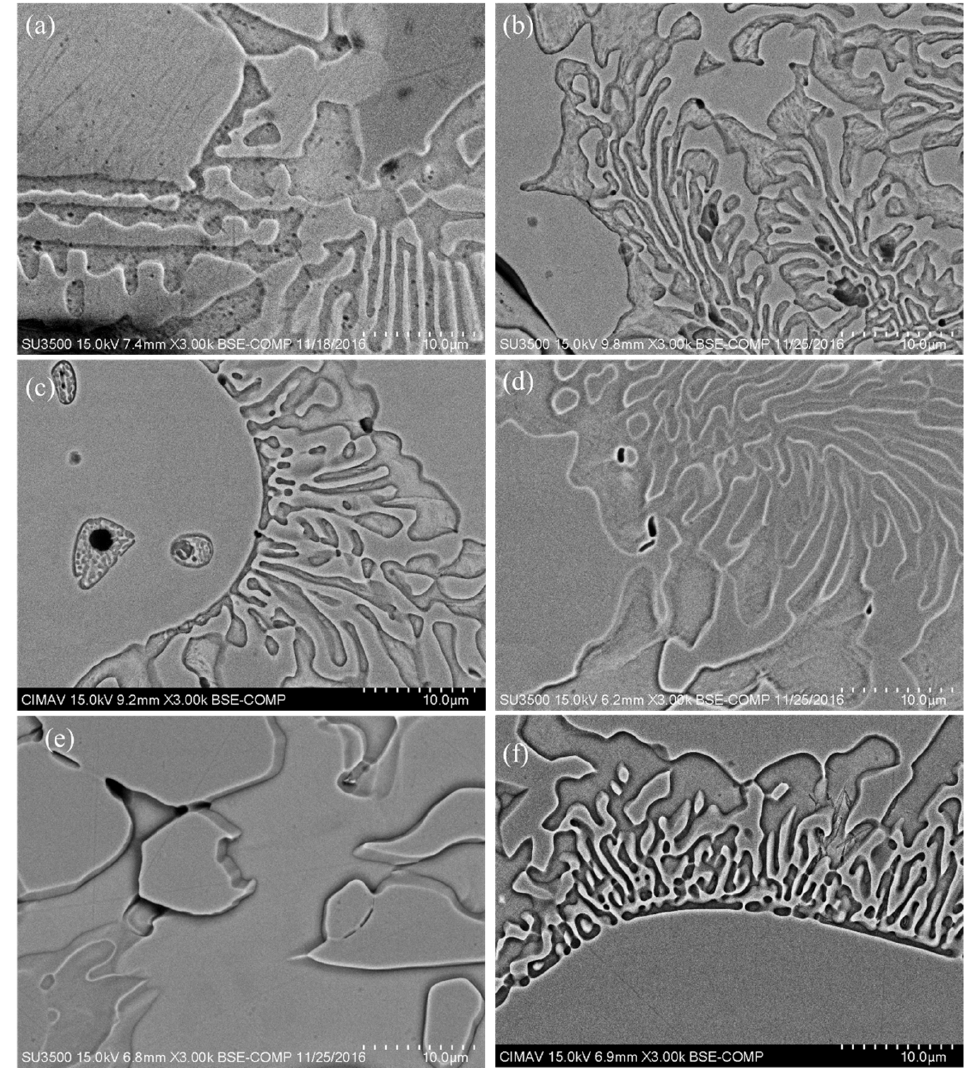
Figure 5. SEM cross-sectional micrographs of the hardfacing coatings sintered in six different atmospheres: ( a ) 10C, ( b ) 9C, ( c ) 7C, ( d ) 5C, ( e ) 3C and ( f ) 1C.